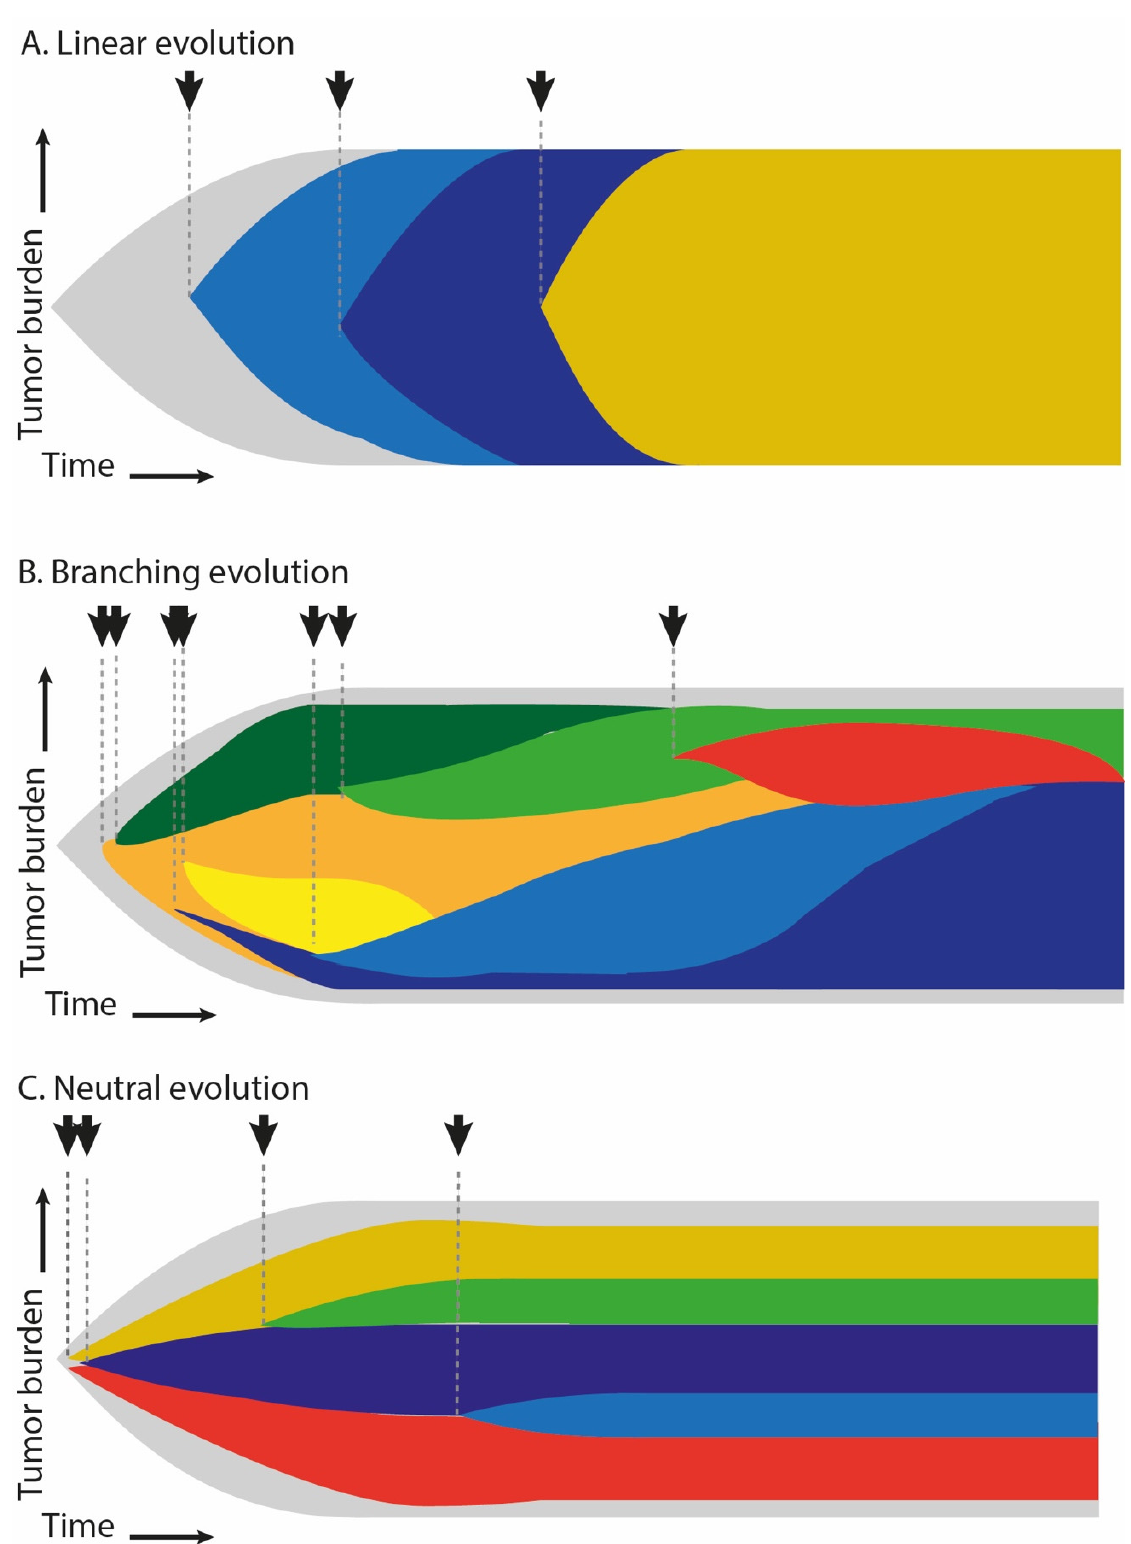
Figure 2. Main models of clonal evolution in multiple myeloma. Each color represents a single subclone. Progeny subclones arising during evolution are marked with arrows.